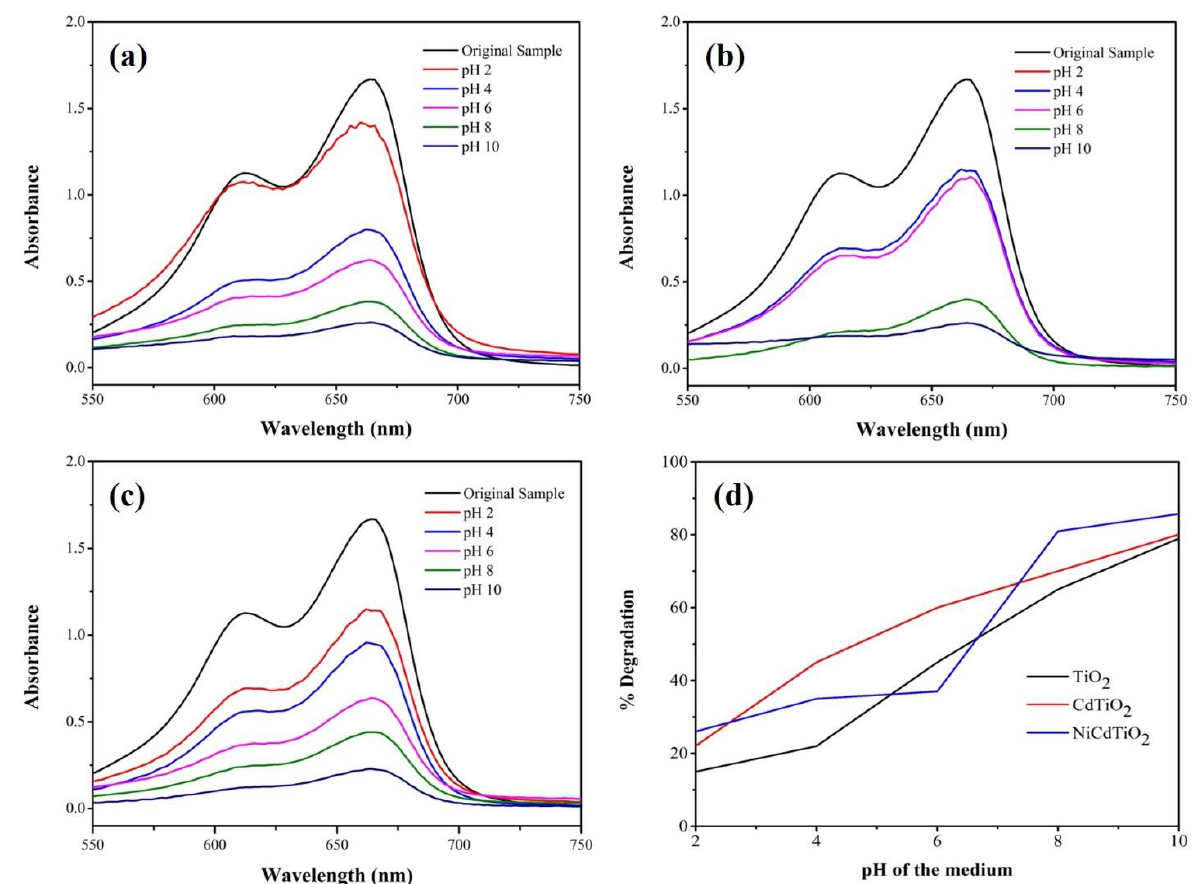
Figure 13. UV – VIS spectra of MB dye photodegraded in different pH medium in the presence of ( a ) Figure 13. UV–VIS spectra of MB dye photodegraded in different pH medium in the presence of TiO 2 ( b ) CdTiO 2 ( c ) NiCdTiO 2 ( d ) Comparison of %degradation of MB dye. ( a ) TiO 2 ( b ) CdTiO 2 ( c ) NiCdTiO 2 ( d ) Comparison of %degradation of MB